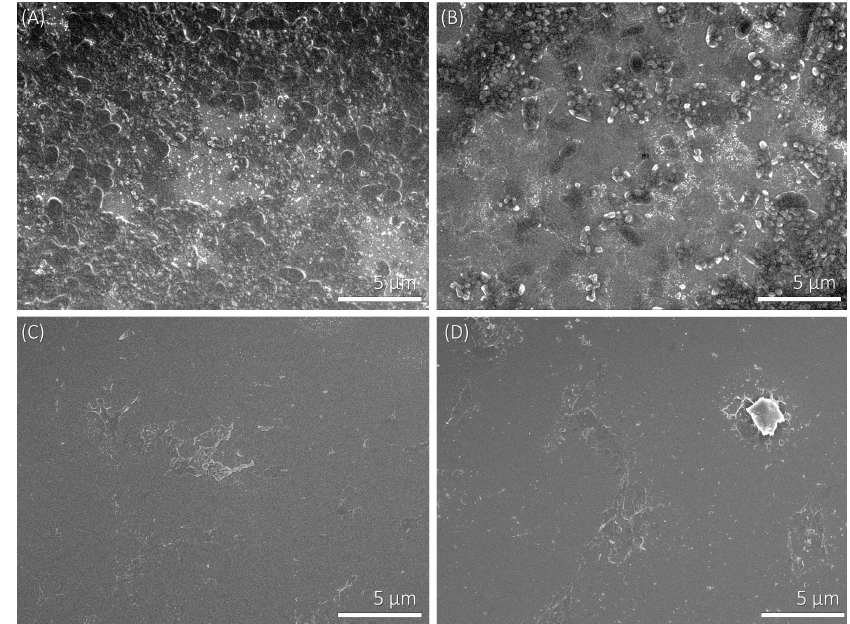
Figure 4. SEM micrographs of P. aeruginosa bacteria adhered on the polyelectrolyte multilayer surface at 5000× magnification. ( A ) Adhered bacteria on a SiO 2 plate which is covered with five polyelectrolyte layers and the terminating layer has a positive electric charge (PAH); ( B ) Adhered bacteria on a SiO 2 plate which is covered with six layers and the last adsorbed layer has a negative electric charge (PSS); ( C ) The negative control of SiO 2 plates with five adsorbed polyelectrolyte layers; ( D ) The negative control of SiO 2 plates with six adsorbed polyelectrolyte layers.